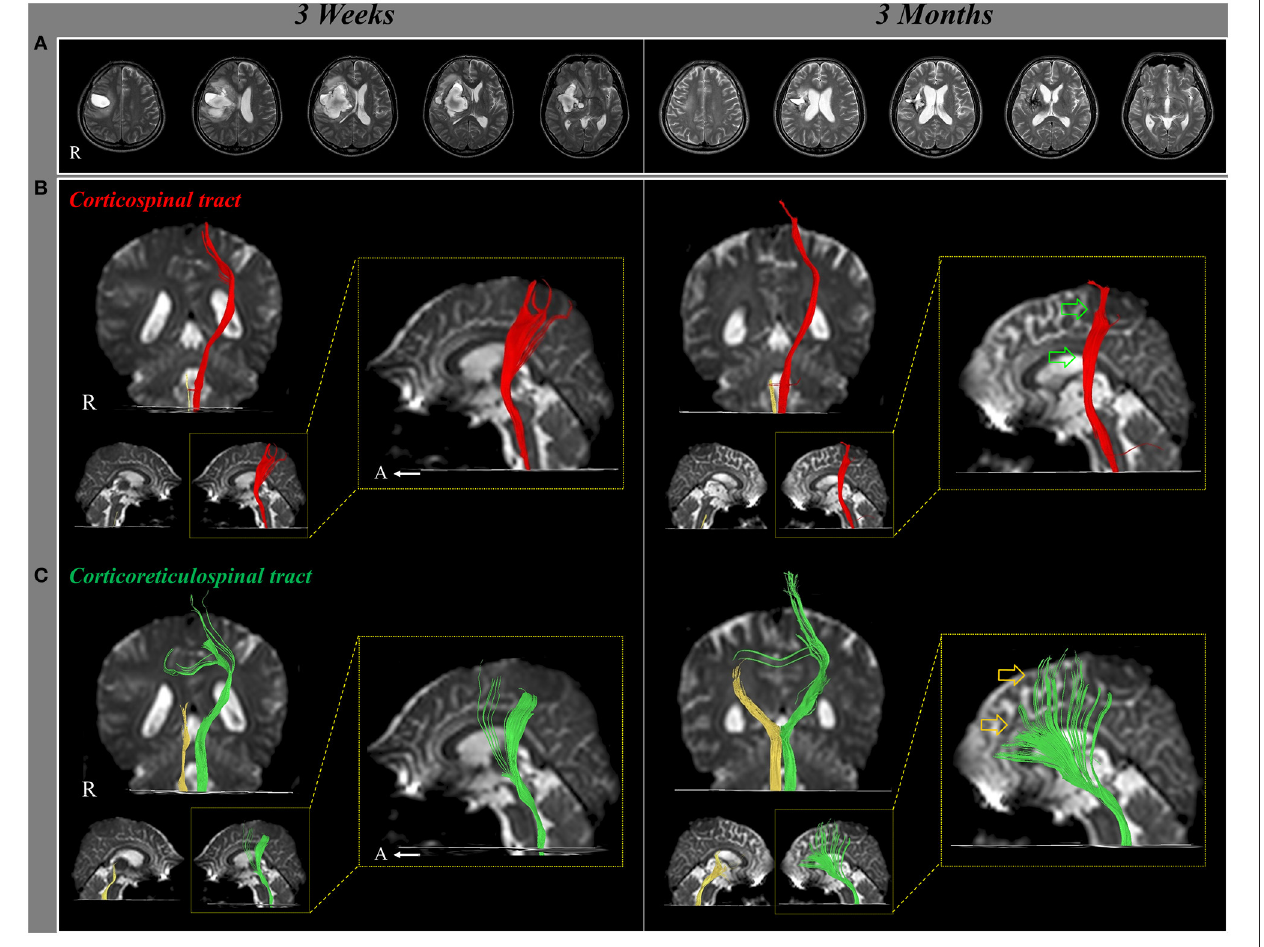
FIGURE 1 | Changes of the neural tracts during the motor recovery of the paretic (left) leg. (A) T2-weighted MR images show a putaminal hemorrhage in the right hemisphere at 3 weeks and 3 months after onset. (B) Result of diffusion tensor tractography (DTT), the right corticospinal tract (CST) shows discontinuation at the brainstem on both 3-week and 3-month DTT. By contrast, on 3-month DTT, the left CST has become thinner (green arrow) compared with 3-week DTT. (C) The right corticoreticulospinal tract (CRT) shows discontinuation below the lesion on both 3-week and 3-month DTT. On 3-month DTT, the left CRT has become thicker (yellow arrow) compared with 3-week DTT (reprinted with permission from Jang and Lee,